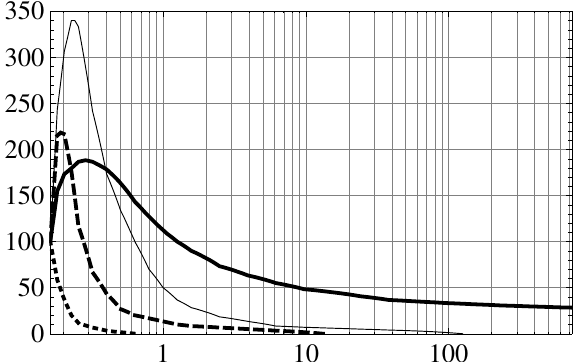
Fig . 1. – Volume of oil and water-in-oil emulsion remaining on the sea surface as a percentage of the original volume spilled versus time (days) for oils belonging to: Group 1 (dotted line), Group 2 (dashed line), Group 3 (thin line) and Group 4 (thick line). Adapted from the ITOPF web page